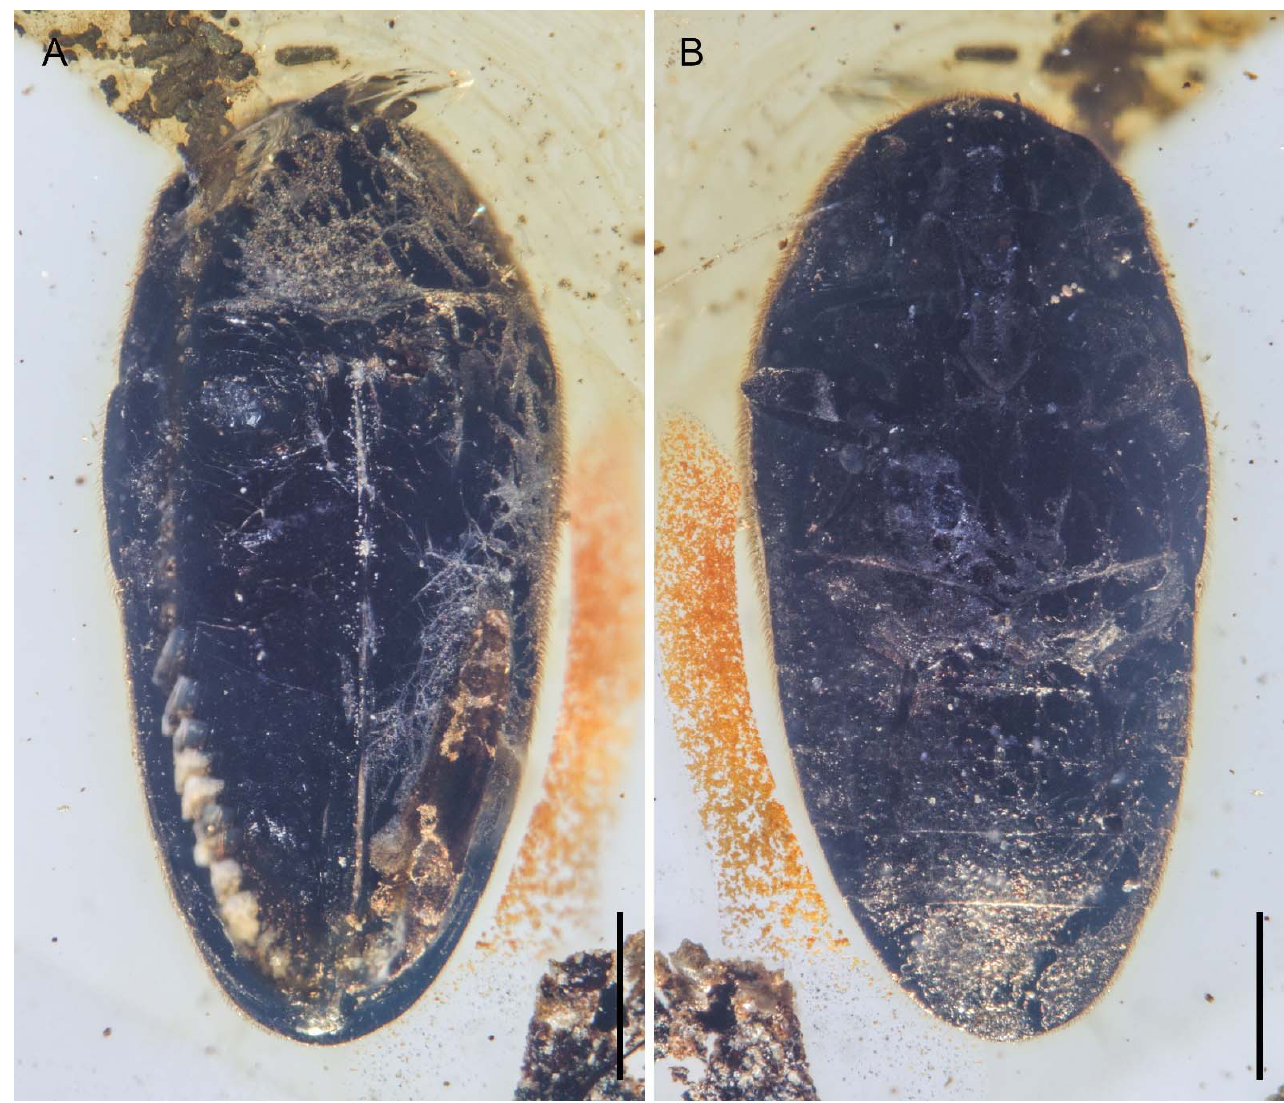
Figure 7. General habitus of Pseudopactopus robustus gen. et sp. nov. , holotype, NIGP173917, under incident light. ( A ) Dorsal view. ( B ) Ventral view. Scale bars: 500 μ m.